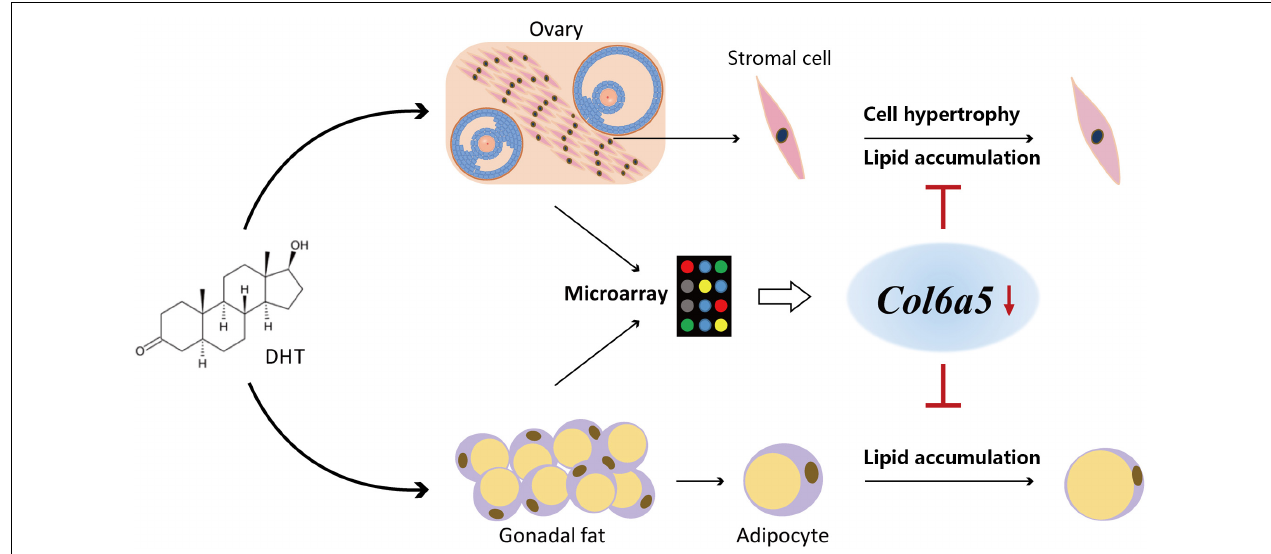
FIGURE 7 | Inhibition of Col6a5 attenuates excessive lipid accumulation induced by DHT. DHT acts directly on ovarian and gonad fat cells, leading to lipid metabolism disorder, which in turn leads to excess lipid accumulation and cell hypertrophy. Inhibition of the expression of our screened target gene Col6a5 could alleviate DHT-induced excess lipid accumulation, hypertrophy and abnormal metabolism-related gene